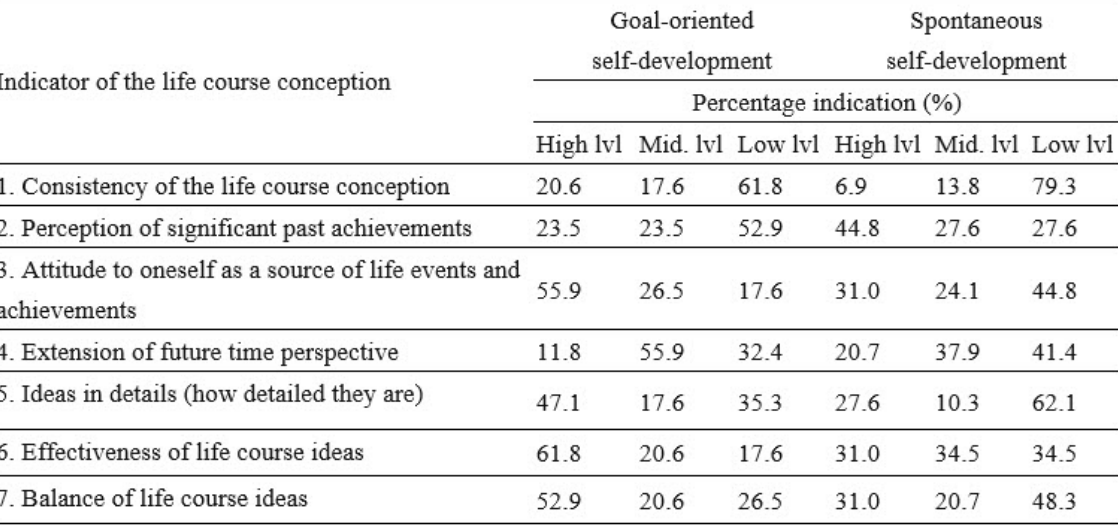
Table 2. Indicators of the life course conception for students with goal-oriented and spontaneous